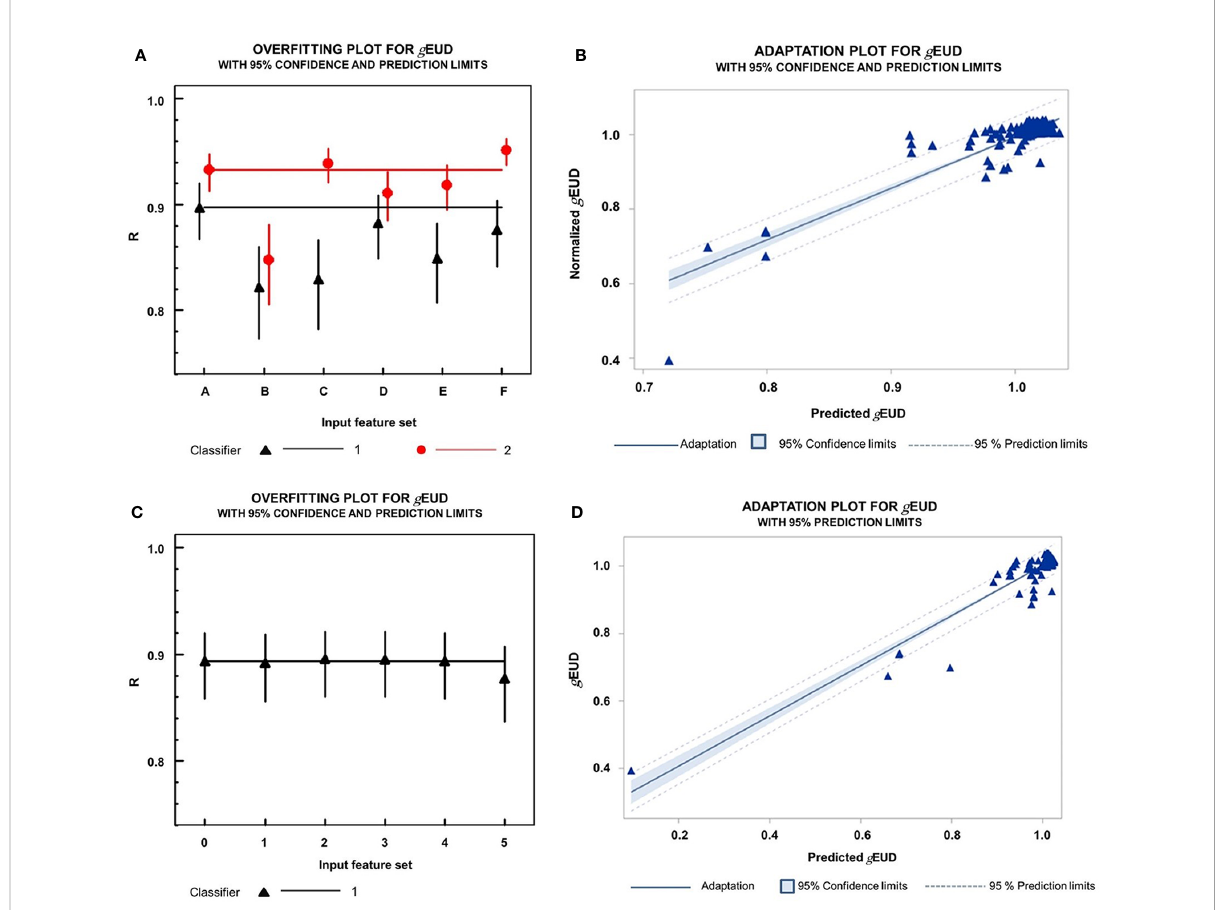
FIGURE 8 (A) Over fi tting plot on the dependence of classi fi er performance with 10-fold cross-validation on the composition of the input feature set. The Pearson correlation coef fi cients R for the closeness of a linear relation between the g EUDi values directly calculated from the dose – volume histograms of the 218 fractions and the g EUDi values predicted by the respective classi fi er. Black triangles up 1 : cross-validated random forest classi fi ers. Red circles